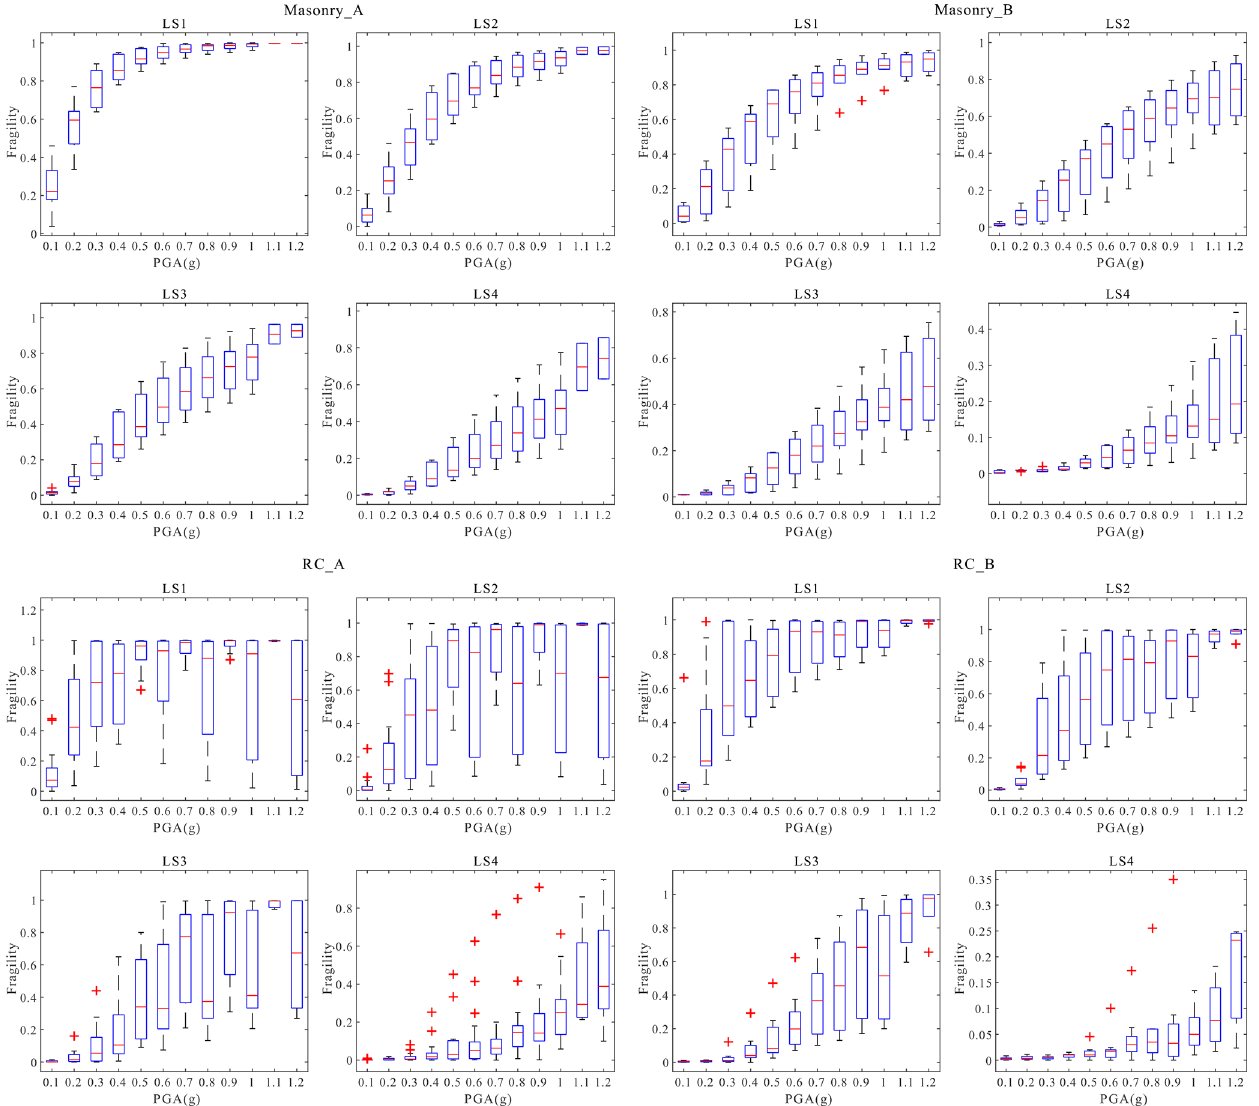
Figure 6. Outlier check using the box-plot method for analytical fragility data. Twelve PGA levels are used to group the discrete analytical fragility datasets: 0.1–1.2g. “A” and “B” represent the pre-, low and moderate level and the high seismic resistance level, respectively (more classification details are available in the Supplement). LS1, LS2, LS3 and LS4 are the four damage limit states. Outliers are marked by red crosses, and the red line within each box indicates the 50% quantile fragility